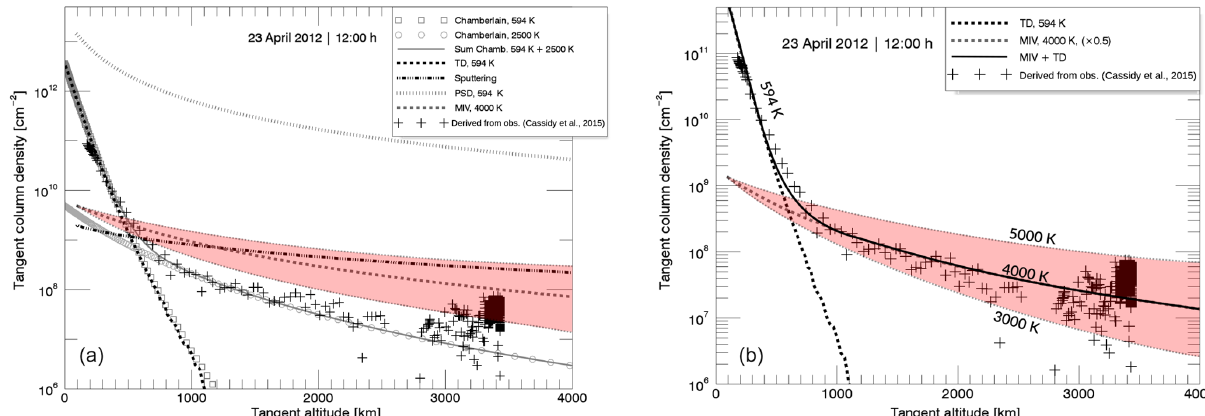
Figure 4. (a) Plots of the derived TCD from observations (black crosses), of the results from our calculations with no correction factors, and of the results using the Chamberlain model. The resulting TCD profiles from our MC model are plotted as follows: TD is the dashed black curve, MIV between 3000 and 5000K is the shaded red area, the dashed-grey curve is MIV with a mean temperature of 4000K, SP is the dashed–dotted grey curve, and PSD is the vertical-dash curve. The resulting profiles using the Chamberlain model are represented as the square- and circle-symbol curves. The sum of the two Chamberlain profiles represented by the solid light-grey curve. (b) Plots of the derived TCD from observations (black crosses) and of the results from our calculations: the dashed black curve is for TD, the results for MIV between 3000 and 5000K are the shaded red area, the dashed grey curve is MIV with a mean temperature of 4000K. MIV curves were multiplied by one-half. The sum of TD and MIV profiles is shown as the solid black